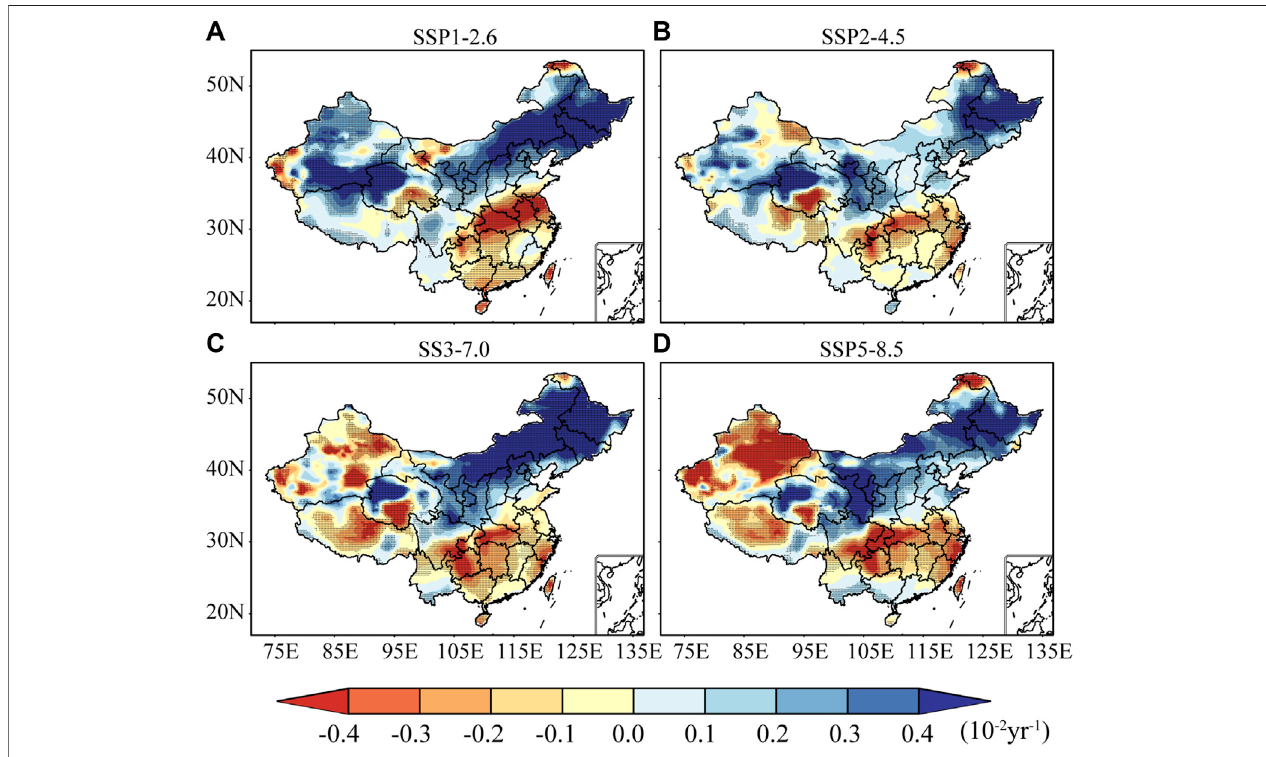
FIGURE 6 | Spatial distributions of the annual mean SSMI trend on four future scenarios in the period of 2015 – 2100 for CMIP6 DL in China. The dots indicate the trend passing the 5% signi fi cance